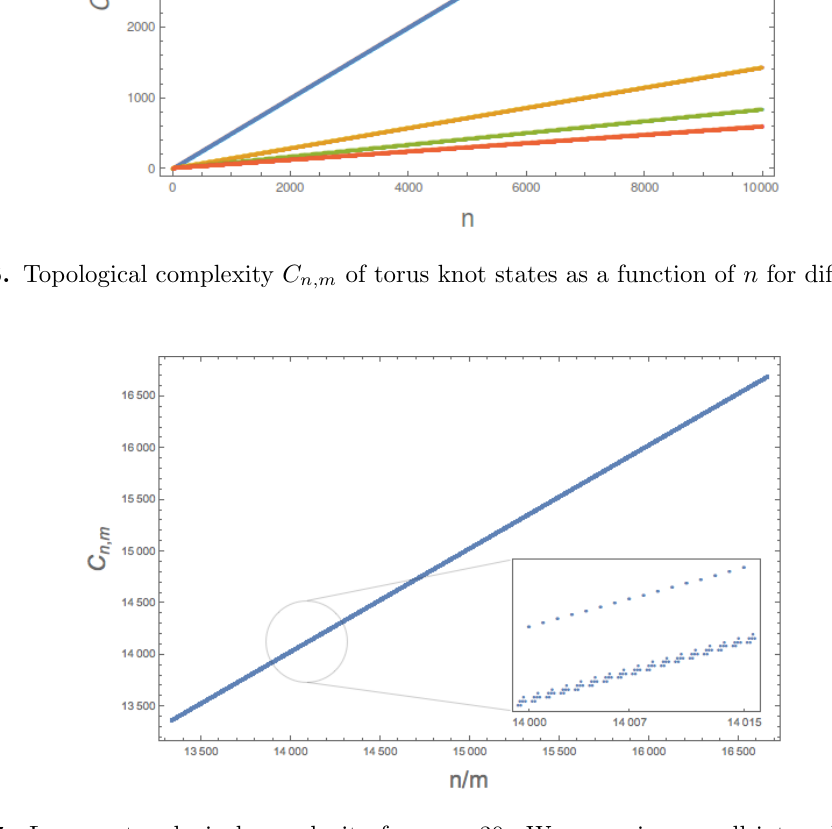
Figure 7. Large n topological complexity for m = 30. We zoom in a small interval to show its (cid:12)ne